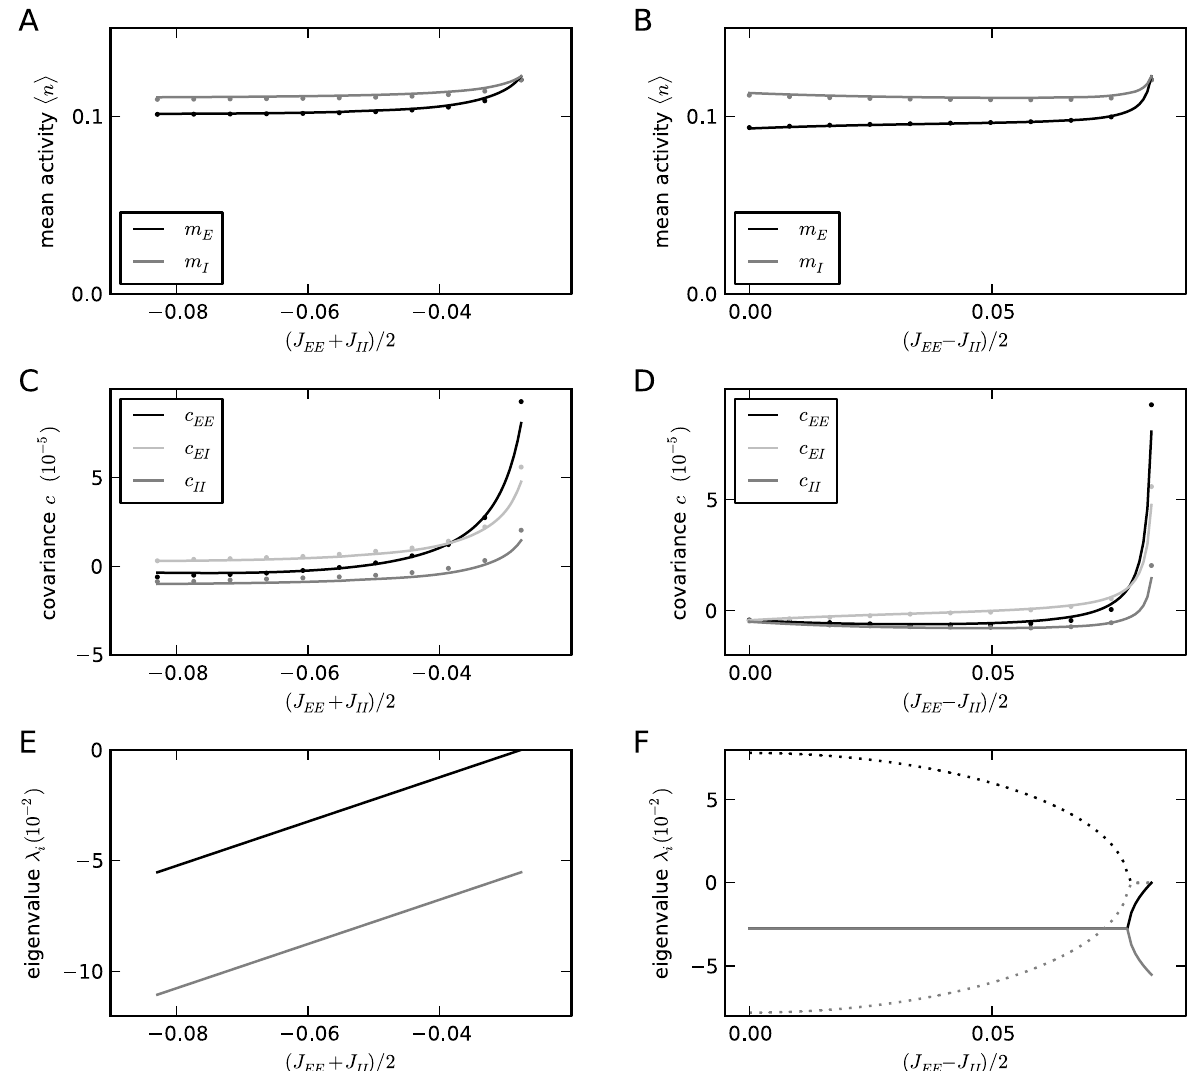
Figure 8. Connectivity structure determines correlation structure. In the left column (A,C,E) c 1 ~ ( J EE z J II ) = 2 is the independent variable, in the right column (B,D,F) c 2 ~ ( J EE { J II ) = 2 . A , B Mean activity in the network as a function of the structural parameters c 1 and c 2 , respectively. C , D Correlations averaged over pairs of neurons. Dots obtained from direct simulation, solid curves given by theory (24) E , F Eigenvalues (30) of the population-averaged connectivity matrix; solid curves show the real part, dashed curves the imaginary part.